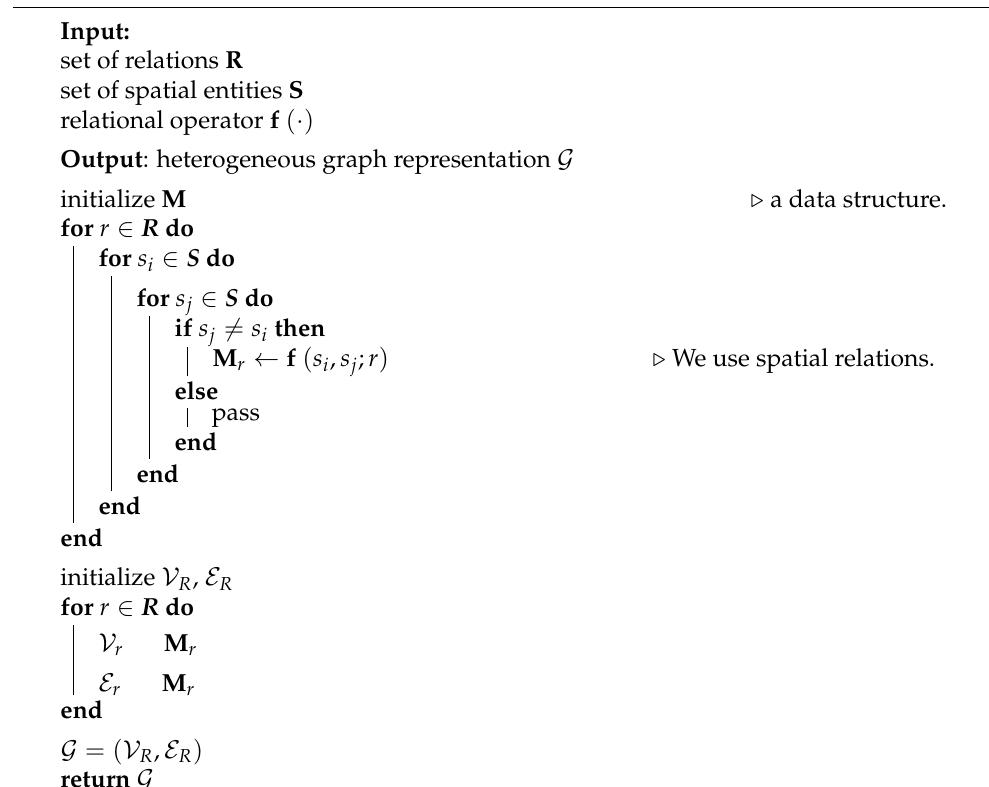
Algorithm 1: Derive Heterogeneous Graph Representation